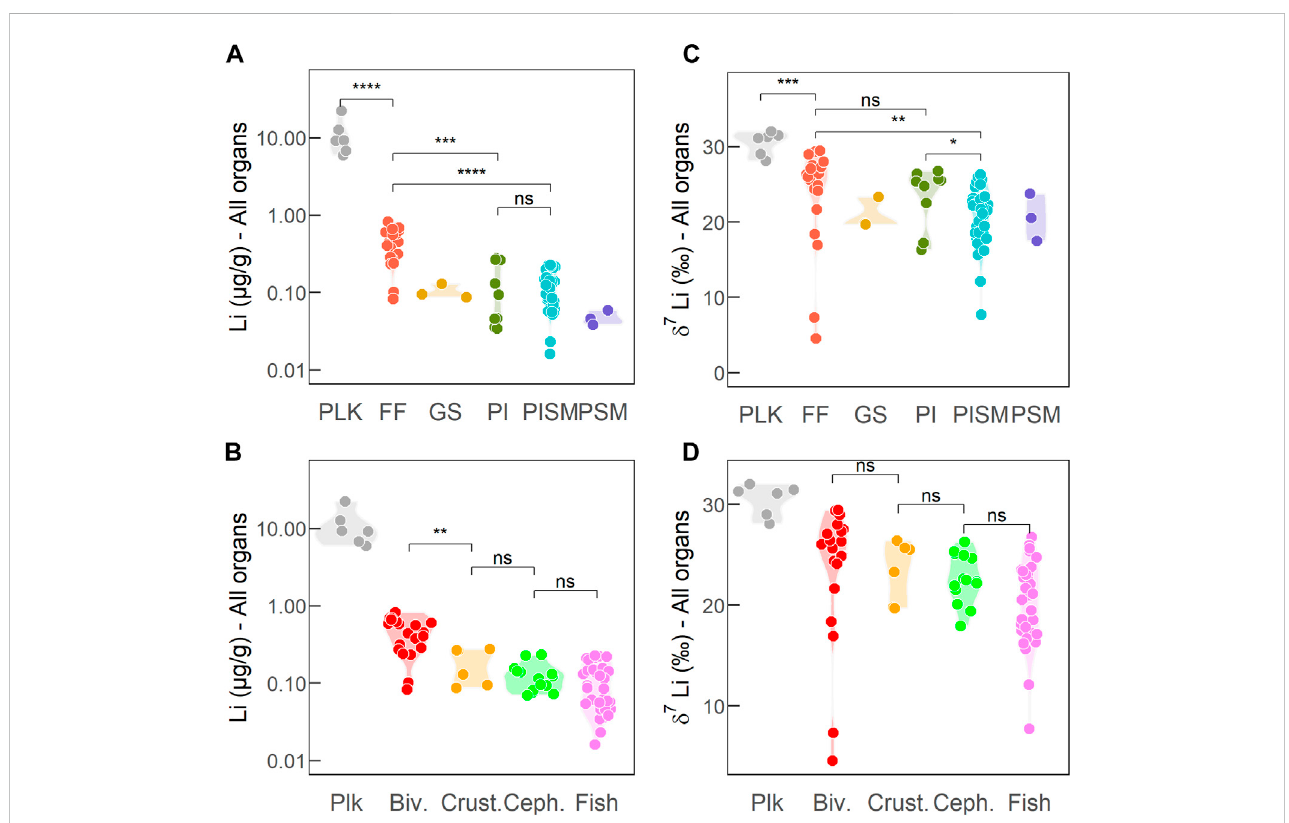
FIGURE 3 Li concentrations (A,B) and Li isotope compositions (C,D) in the whole body ( ȁ whole ” ) and different tissues of marine organisms vs. (B,D) taxonomic groups and (A,C) trophic groups. Abbreviations: Plk, plankton, Biv., bivalves; Crust., crustaceans; Ceph., cephalopods. Trophic groups are: FF, fi lter-feeders; GS,grazers/scavengers;PI, predators ofinvertebrates;PISM, predatorsof invertebrates andsmall fi sh;PSM, predatorsofsmall fi sh. Liconcentrationsare from Thibon and Weppe et al., 2021c, except for zooplankton (this